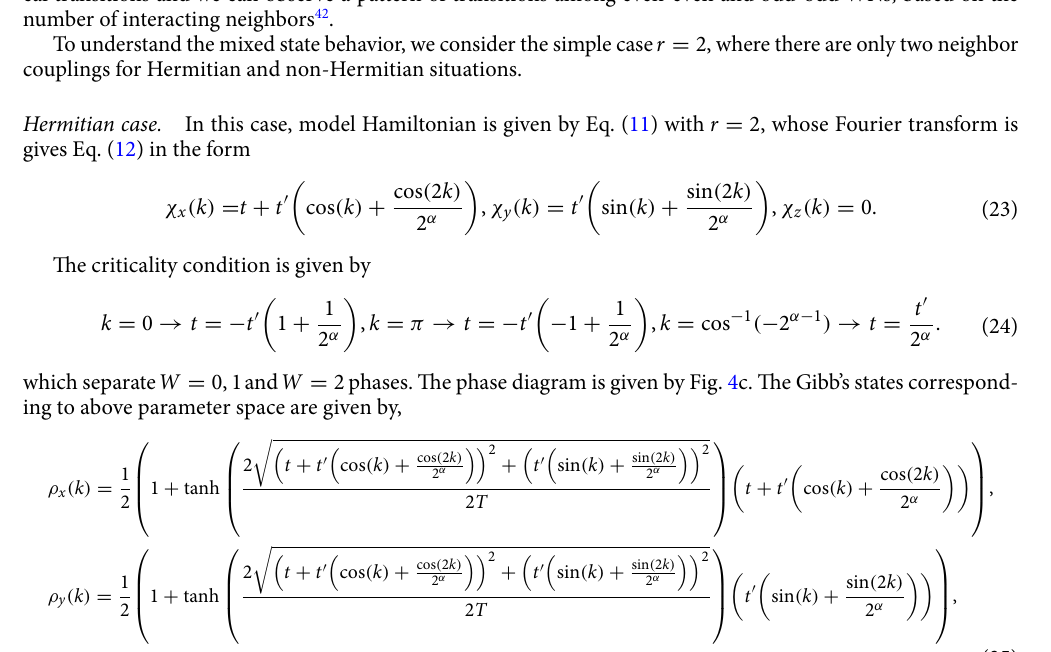
1 case (Fig. 3b1,b2). For = 0 (Table 1). →